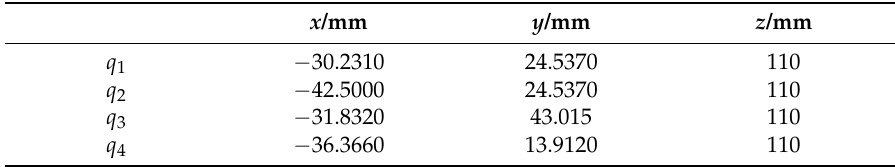
Table 1. Coordinates of the optimal measurement